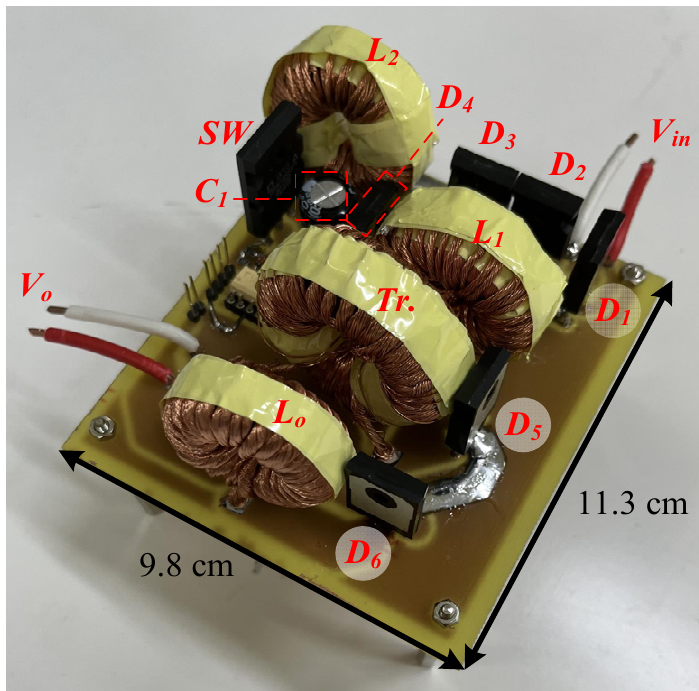
Figure 21. The photograph of the CHSDC.